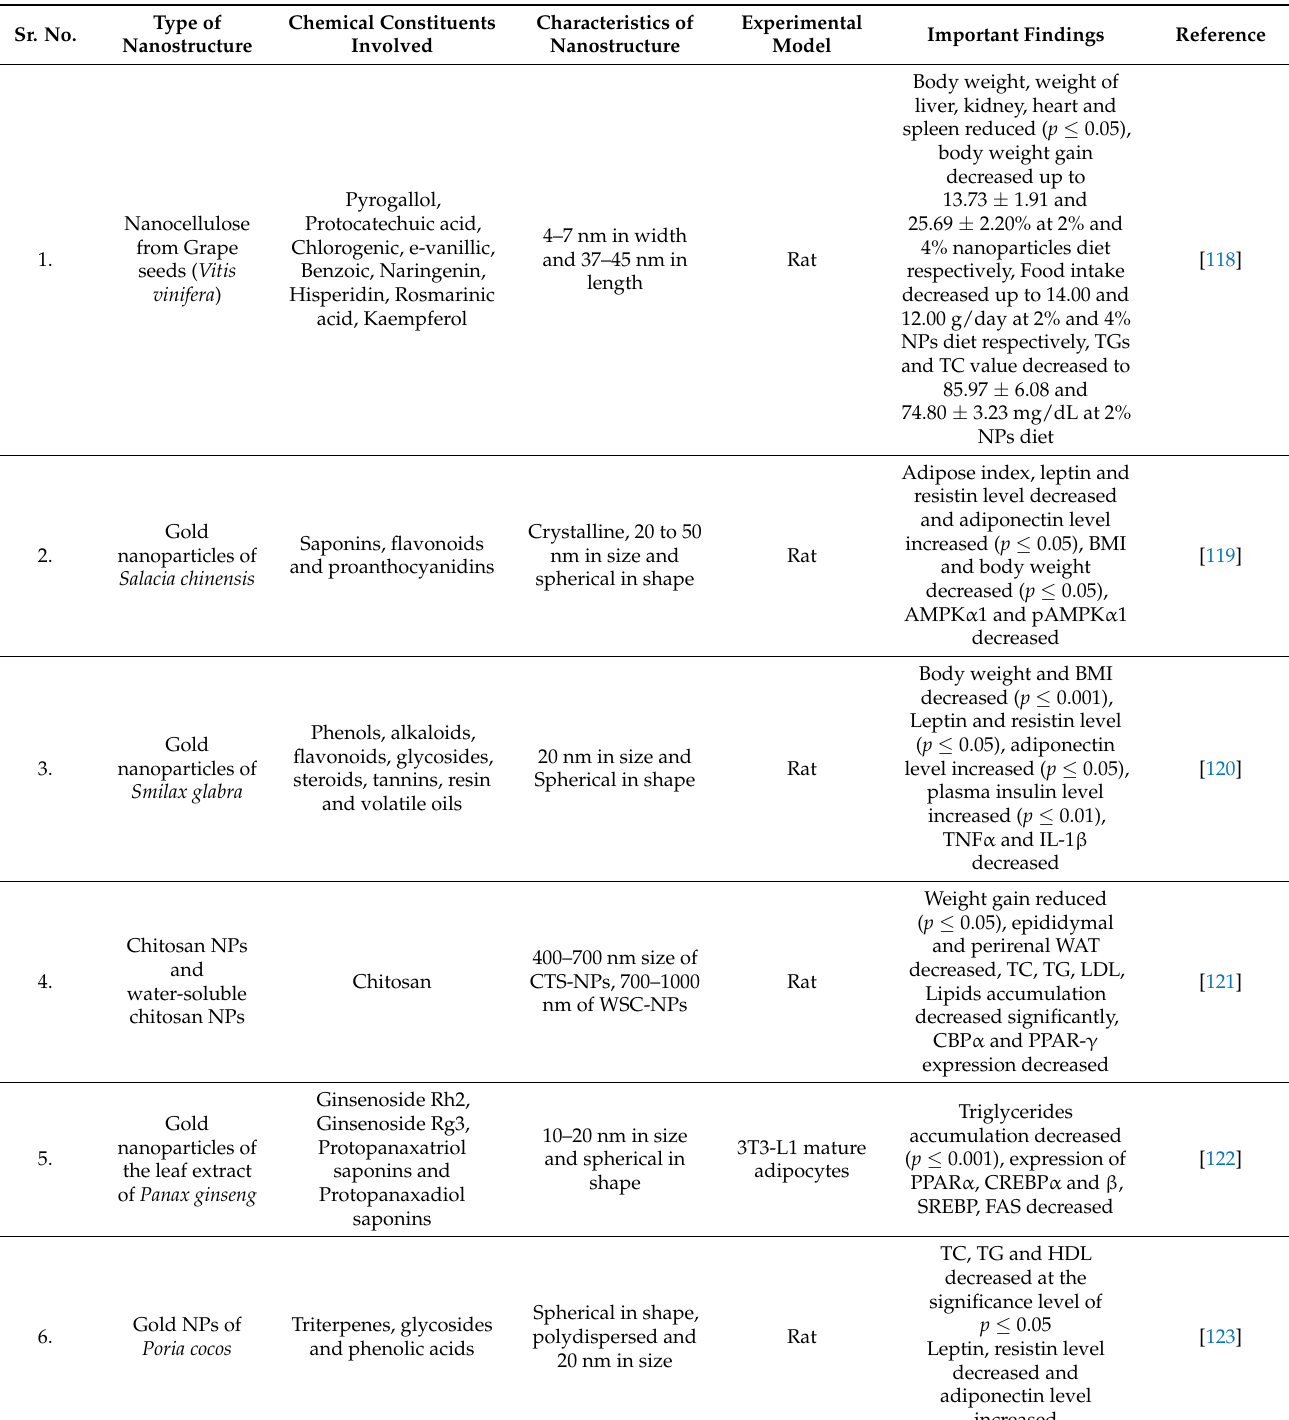
Table 2. Biologically synthesized metallic nanoparticles and nanoencapsulated secondary metabolites showing anti-obesity